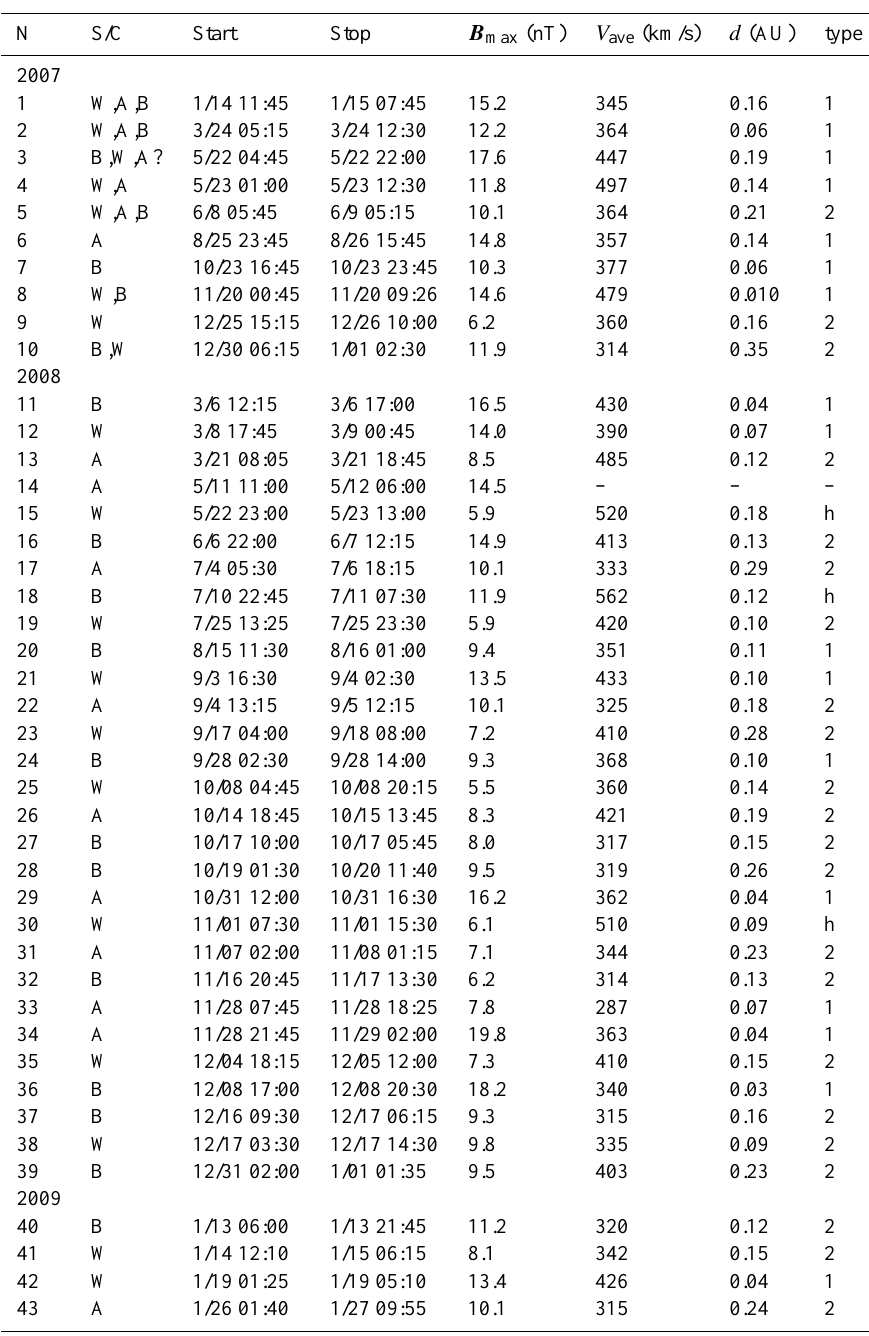
Table 1. ICMEs identified from the solar wind measurements by STA (A), STB (B) and Wind (W). Columns give the event number ( N ), spacecraft that observed the ICME (S/C), start and end times of the ICME (time given at the S/C indicated first in the second column), magnetic field maximum value ( B max ) , average solar wind speed ( V ave ), and the radial diameter ( d ) calculated as the product of average speed and the ICME duration. The last column indicates the group of the ICME belongs, 1: in front of the high speed stream, 2: embedded in the slow solar wind, h: high speed solar